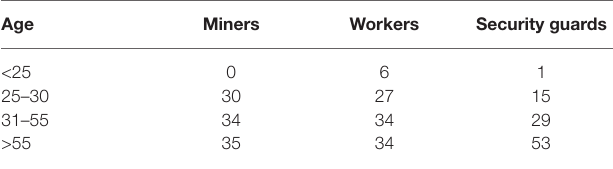
TABLE 1 | Age distribution of participants in the sample